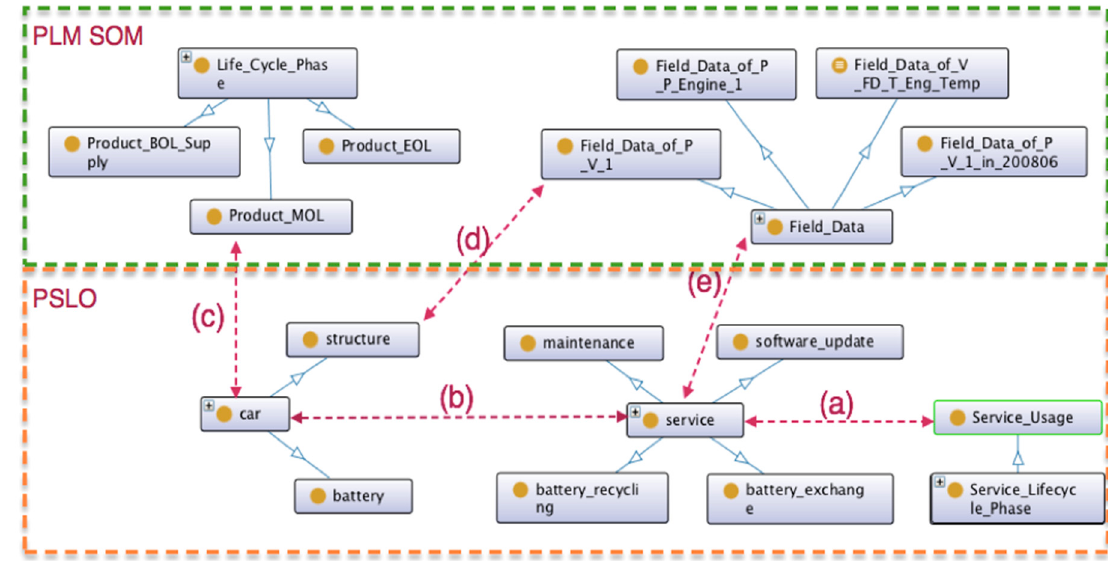
Figure 5. Global view of the physical product and product-service ontology model.